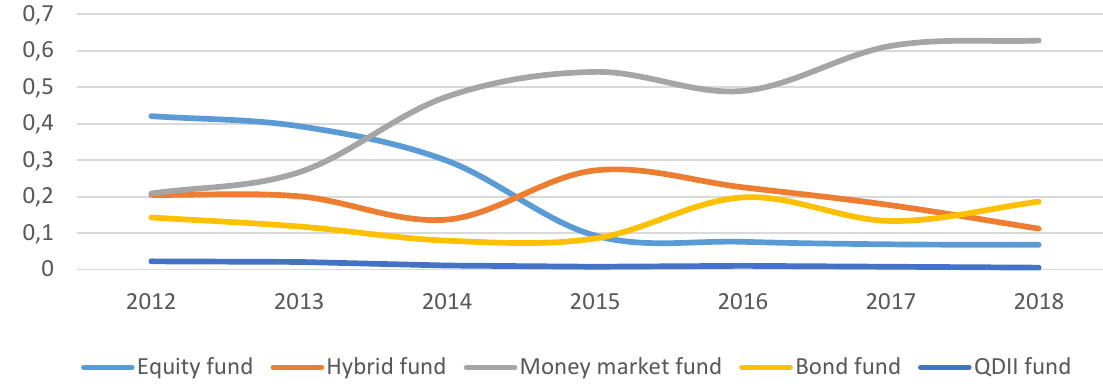
Figure 3. Number of open-end funds by type in the Chinese mutual fund industry